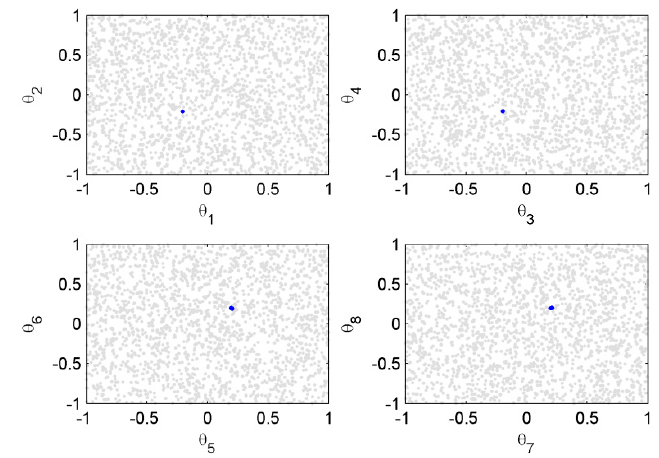
Figure 5. Scatter plot graph of posterior (in blue) and prior (in gray) samples of the model parameters (case 1).